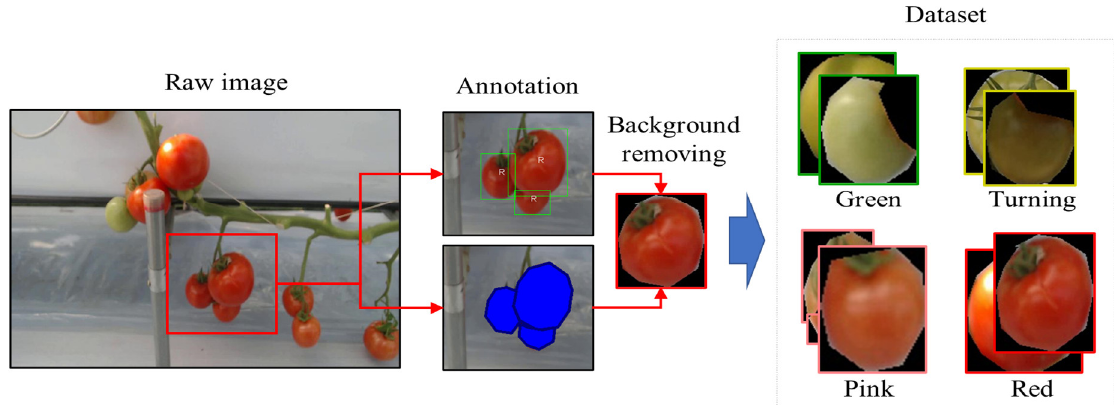
Figure 2. The tomato object annotation and background elimination process.